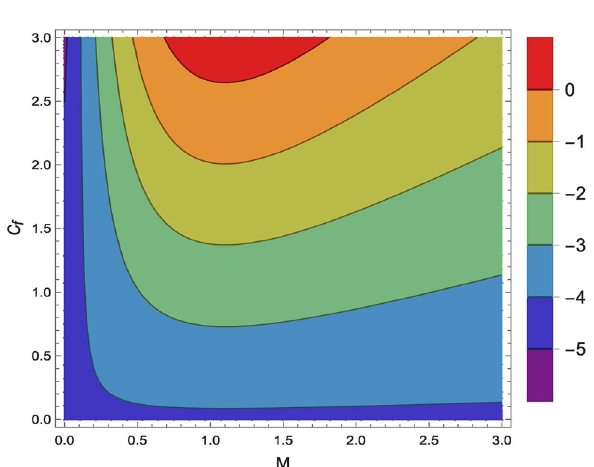
Figure 26. C f due to M .